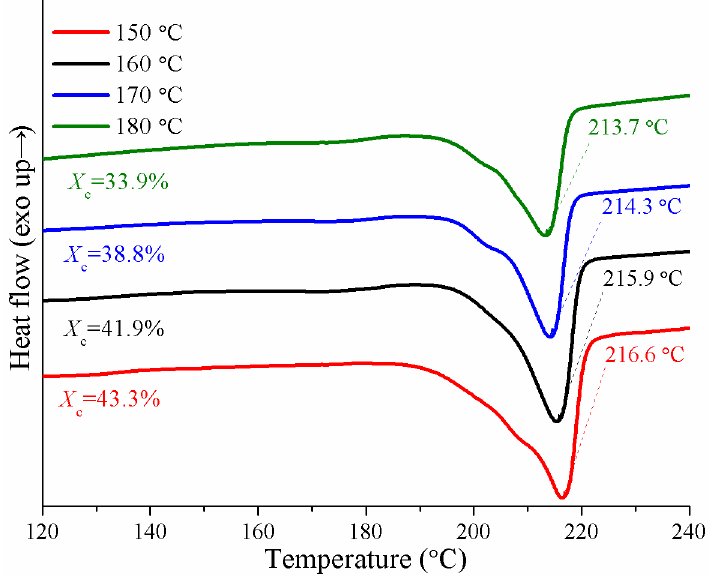
Figure 9. Degree of crystallinity and melting point of PA-6 matrix for various heating zone temperature measured by DSC.